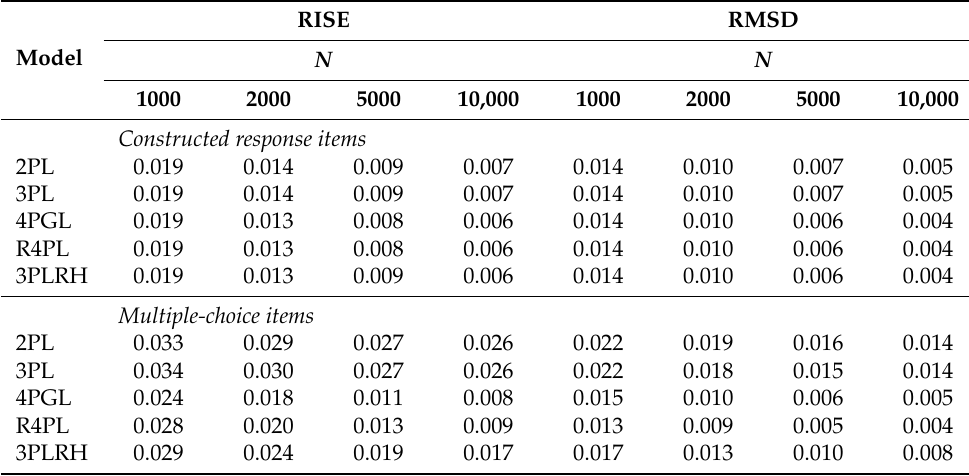
Table 3. Simulation study: root integrated square error (RISE) and root mean square deviation (RMSD) statistics as a function of sample size N